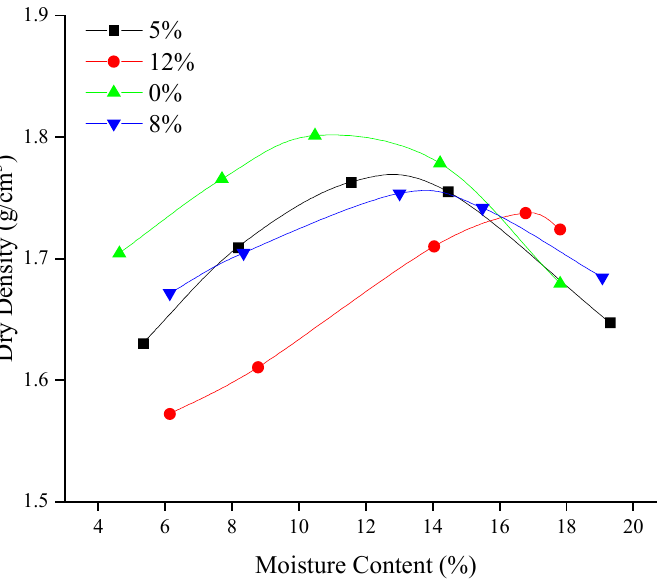
Figure 3. Compaction characteristic of the compacted soils.